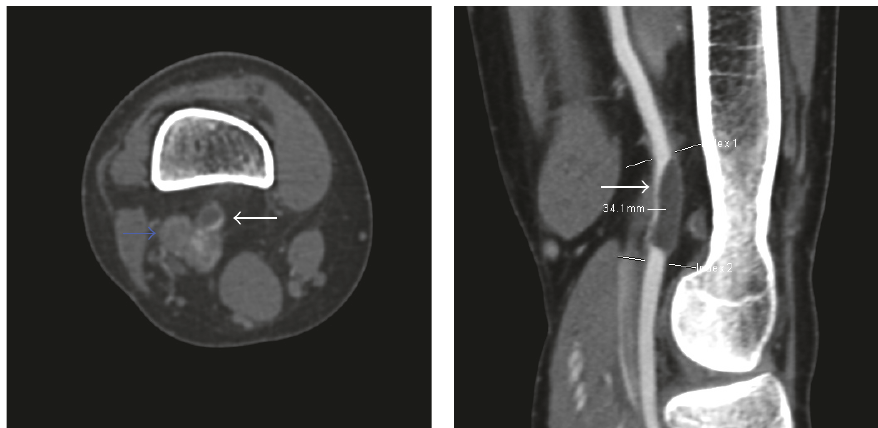
Figure 1: Computed tomography revealed simple cystic lesion at the popliteal artery and stenosis of the artery in this lesion. White arrow: cystic lesion of popliteal artery. Blue arrow: venous aneurysm (it was not diagnosed preoperatively).